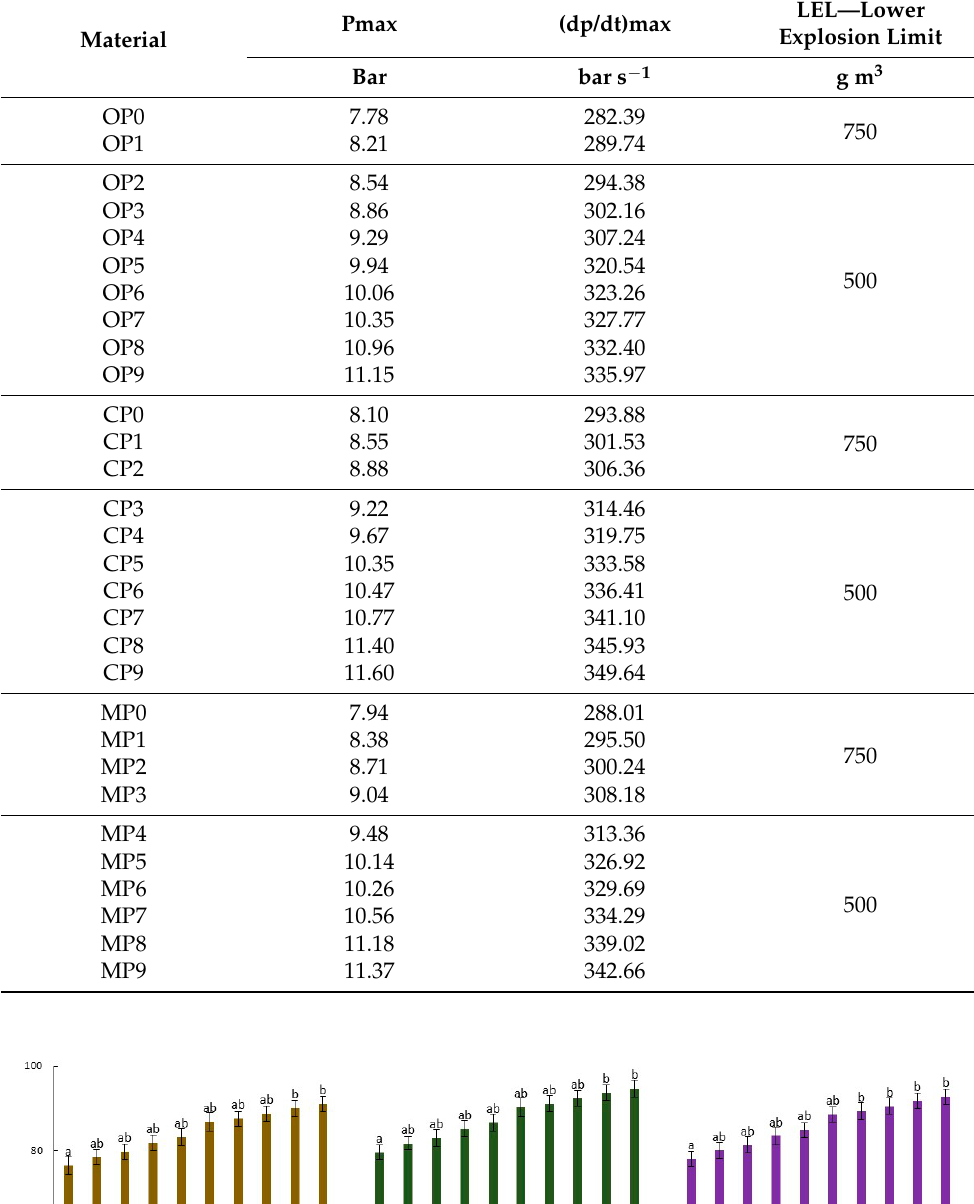
Table 6. Level of lower explosive limit, maximum pressure rise rate, maximum explosion pressure of dust from oak, coniferous, mixed pellets and their pyrolysates.